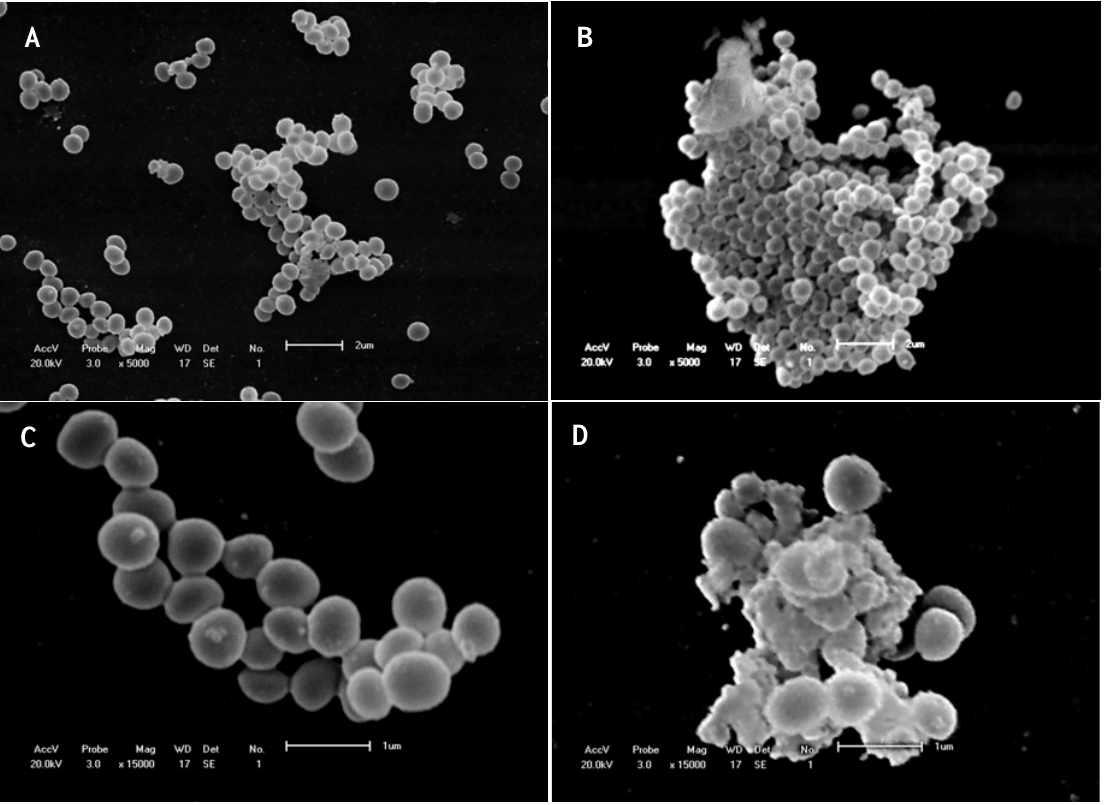
Figure 3. Scanning electron microscopy and transmission electron microscopy of Staphylococcus aureus treated with eupomatenoid-5 obtained from Piper regnellii . A, C, E = control; B, D and eupomatenoid-5 6 µg/mL. Bars A, C = 2 µm; B and D = 1 µm; E and F = 500